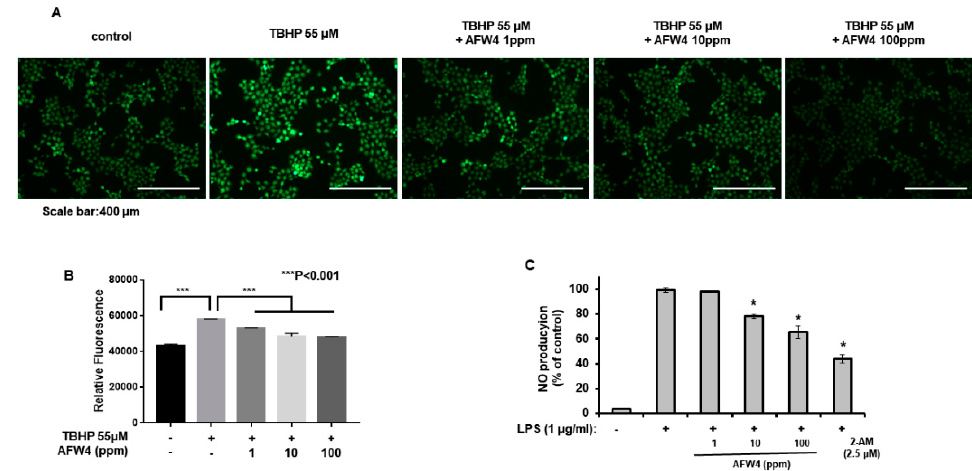
Figure 7. AFW4 exerts antioxidant activity in HaCaT cells. ( A and B ) HaCaT cells were incubated